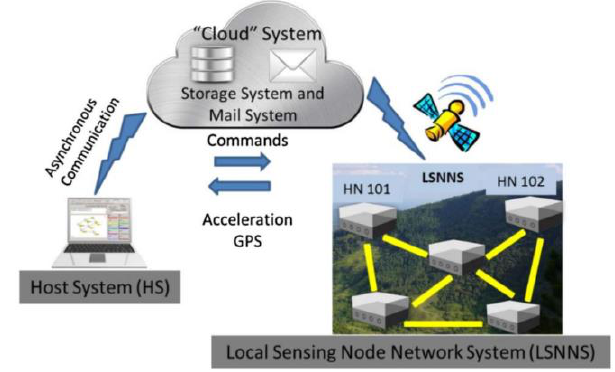
Figure 1. Landslide Monitoring System